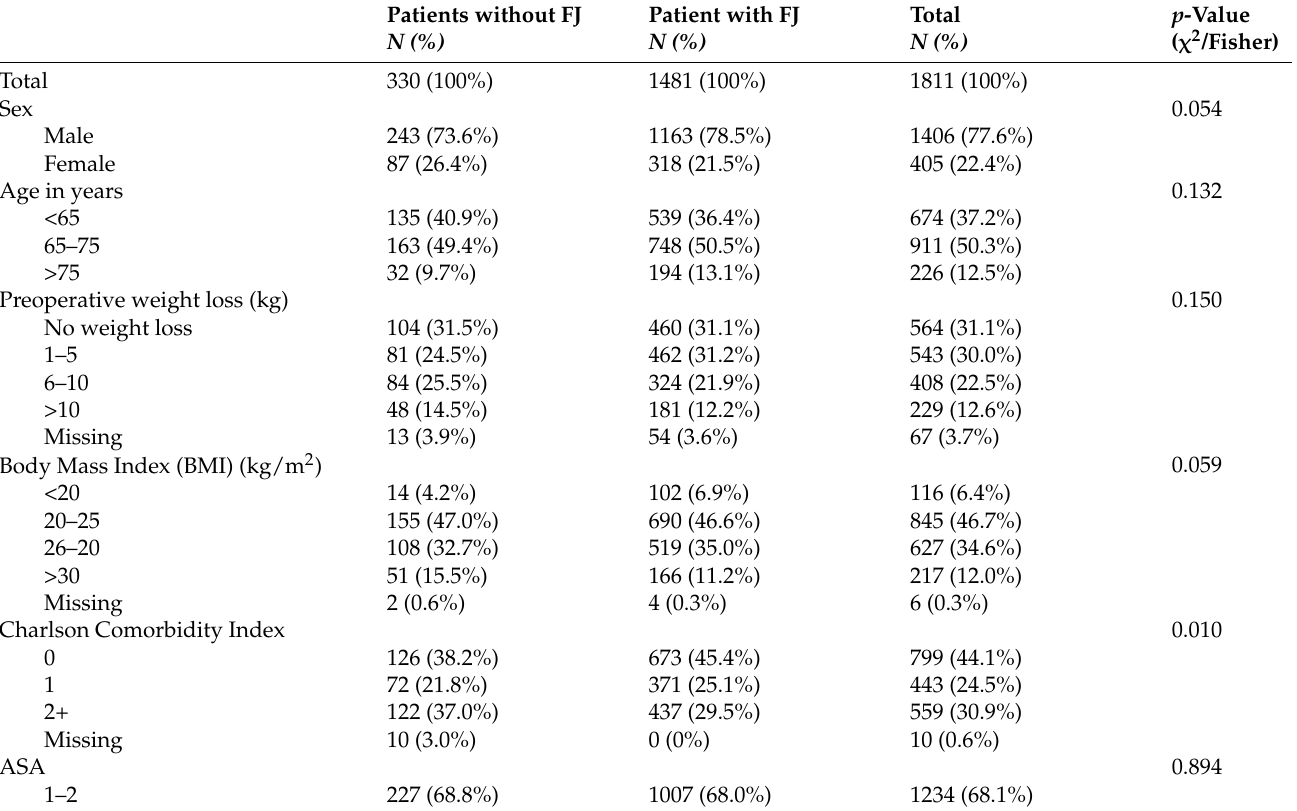
Table 1. Patient, tumor, and treatment characteristics of all patients without and with feeding jejunostomies (FJ).